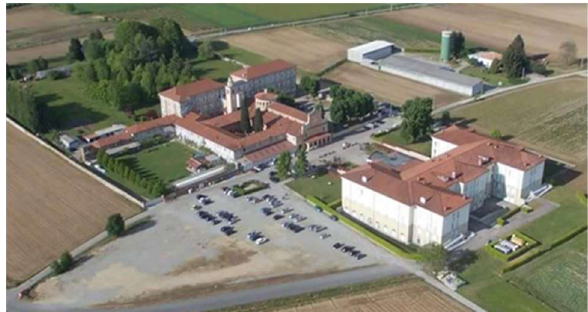
Figure 1. The whole complex with the health care building on the right and the Church and cloister on the left.